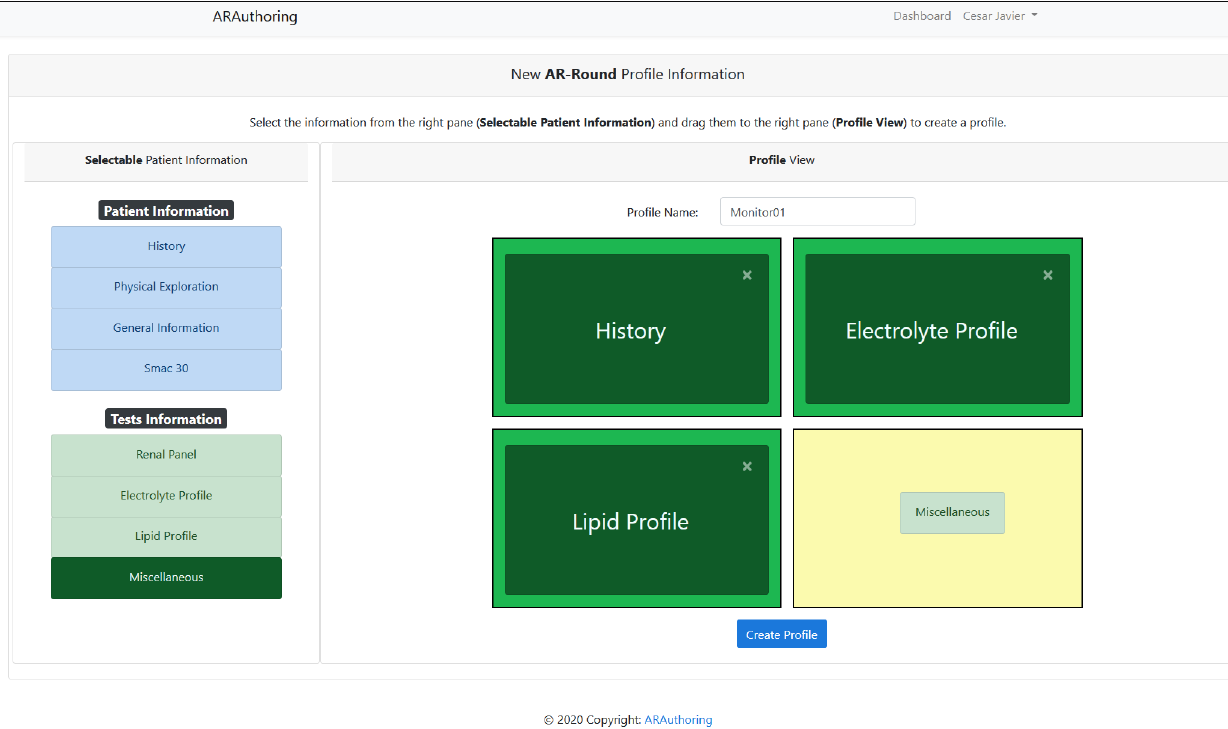
Figure 4. Administrative user dashboard page in